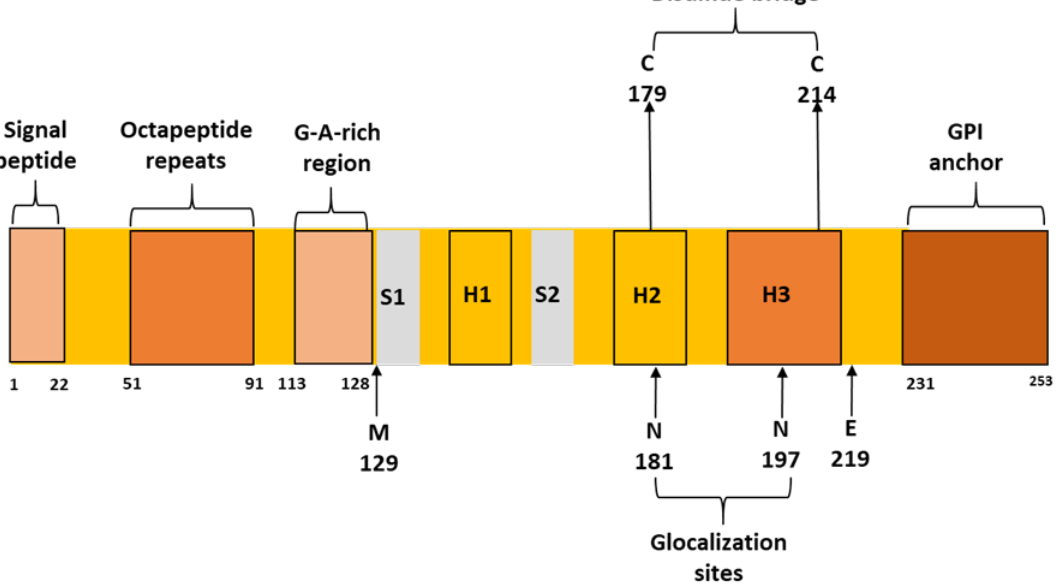
Figure 1. Schematic figure of PrP C with the important domains and residues.